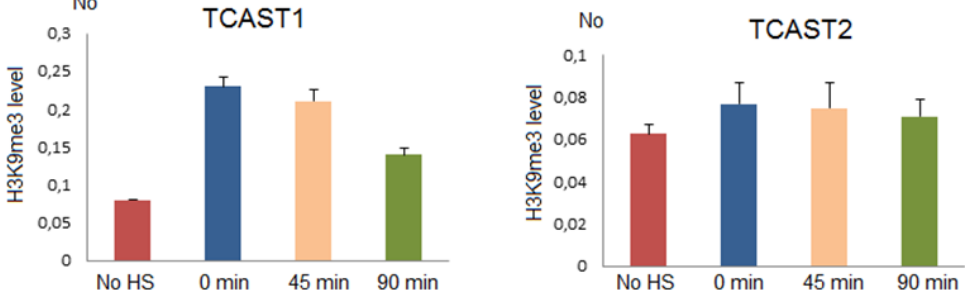
Figure 7. The level of H3K9me3 at TCAST1 and TCAST2 satellite repeats after HS. H3K9me3 levels were measured by ChIP coupled by quantitative real-time PCR at standard conditions (no HS), immediately after 24 h of HS (0 min), at 45 min and 90 min of recovery. No value was normalized using No value of input fraction. Columns show average of three independent experiments and error bars indicate the standard deviations.